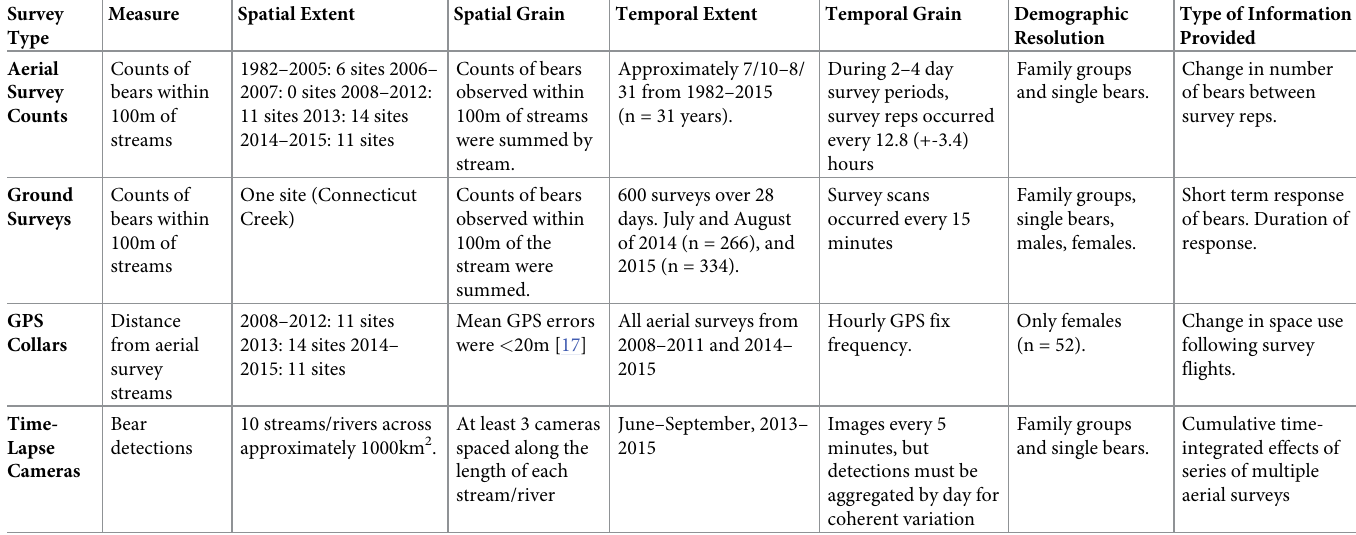
Table 1. Survey/data types and